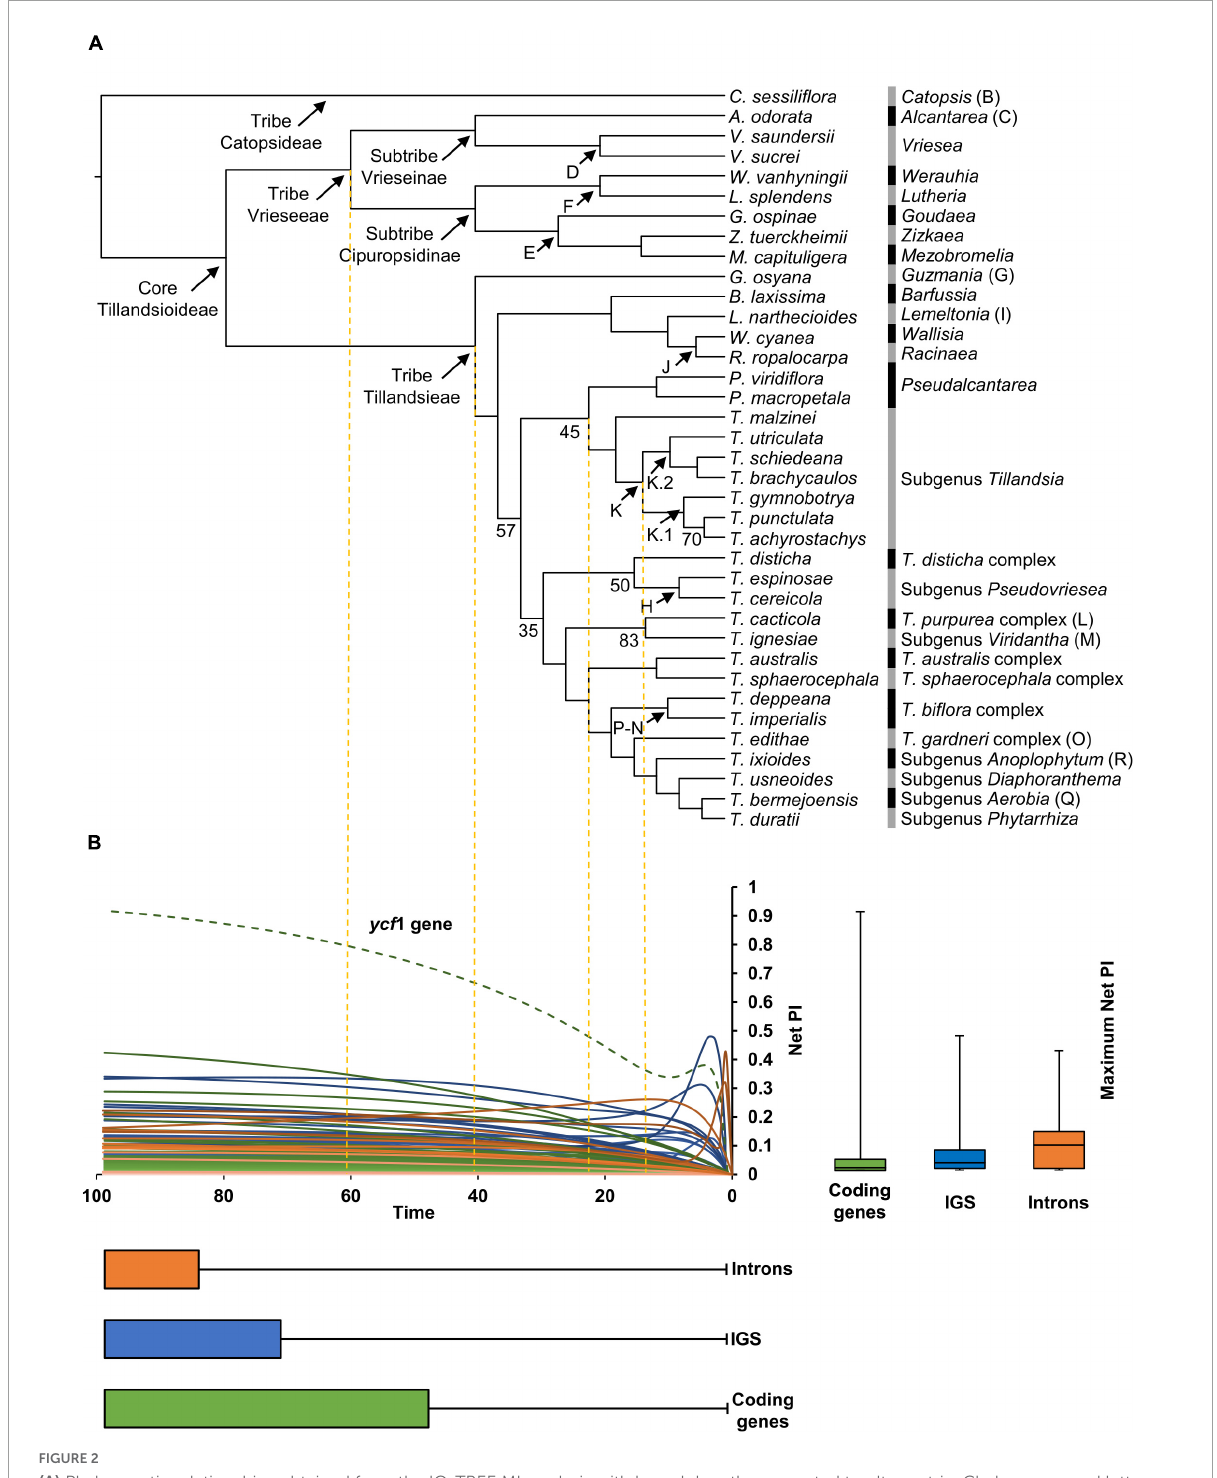
FIGURE2 (A) Phylogenetic relationships obtained from the IQ-TREE ML analysis with branch lengths converted to ultrametric. Clade names and letters identifying genera, subgenera and species complexes follow Barfuss et al. (2016) and Granados Mendoza et al. (2017). Support values are shown below the branches for nodes with BS < 85%. (B) Net phylogenetic informativeness (PI) profiles of plastid coding genes (green), intergenic spacers (blue), and introns (orange). The green dashed curve corresponds to the ycf 1 gene, which surpassed by far the PI of any other marker. Distribution of loci’s maximum net PI values and time at which these values were reached is shown with quantiles 2 and 3 to the right and below the PI profiles, respectively. Whiskers denote maximum and minimum values. The arbitrary time scale of the PI profiles matches the one of the ultrametric tree in (A)